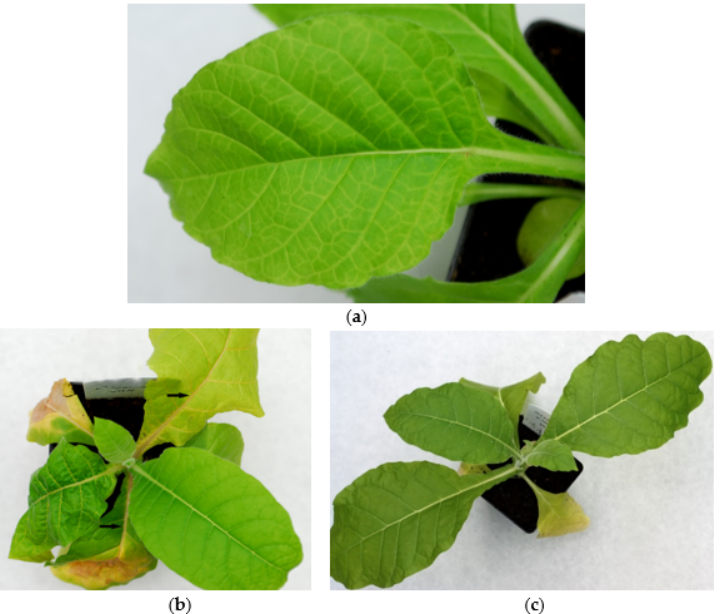
Figure 1. Resistance response of the tested species to the severe PVY isolate four weeks after inoculation: ( a ) vein clearing on leaves of N. mutabilis ; ( b ) vein necrosis on tobacco cultivar VAM (indicated by black arrows); ( c ) control plant of cultivar VAM inoculated only with buffer. Among the tested species, only N. tabacum cv. Burley 21 amplified the Nsyl-elF4E1 marker, which indicated the presence of the Va susceptibility gene in this cultivar (Figure